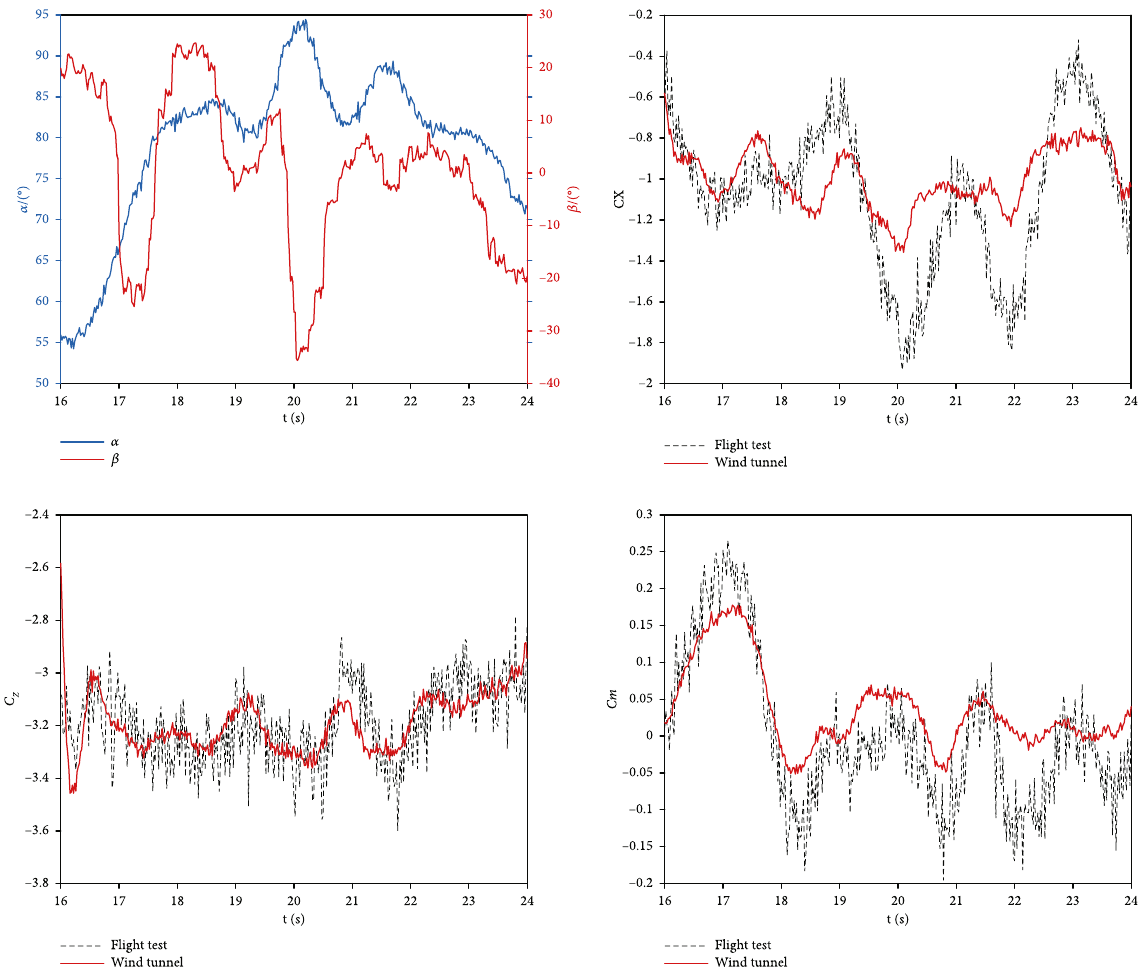
Figure 6: The angles of attack and sideslip measured in the fl ight test; comparison of the fl ight data and the wind tunnel modeling data (e.g., , C , and C C X Z m